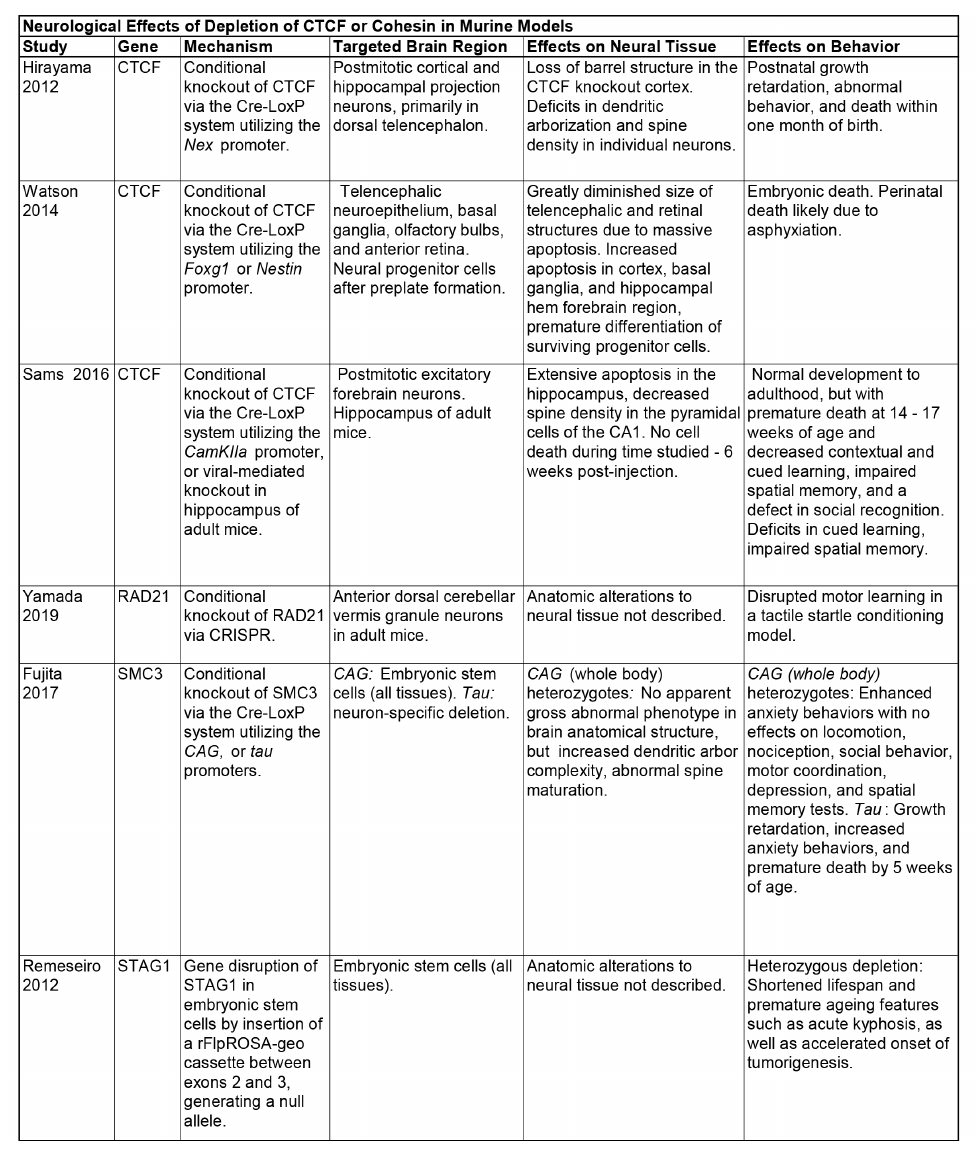
Figure 3. Effects of CTCF and Cohesin Depletion in Murine Models. Summary of effects compiled